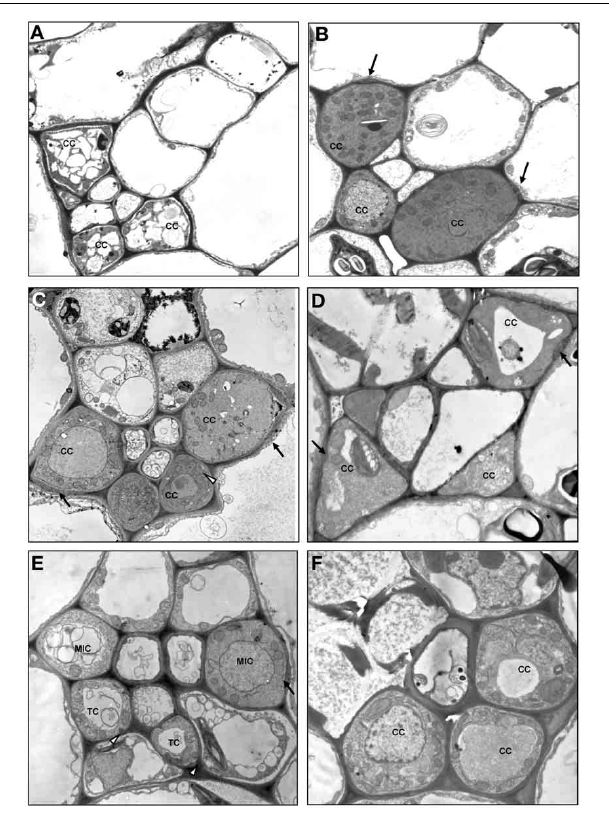
FIGURE 4 | Structure of minor vein phloem, type 1, and type 0. (A) Scutellaria pallida , subtype 1-I; (B) Mimulus guttatus , subtype 1-II; (C) Dracocephalum peregrinum , subtype 1-III; (D) Amsonia tabernaemontana , subtype 1-IV; (E) Asarina barclaiana ; (F) Trachelospermum luikinense , type 0. CC, companion cell; MIC-a, modified intermediary cell subtype a; SE, sieve element; TC, transfer cell subtype b. Black arrows point on plasmodesmal fields, white arrowheads point on cell wall ingrowths. Magnification: (A–D), (F) , × 1750; (E) , ×